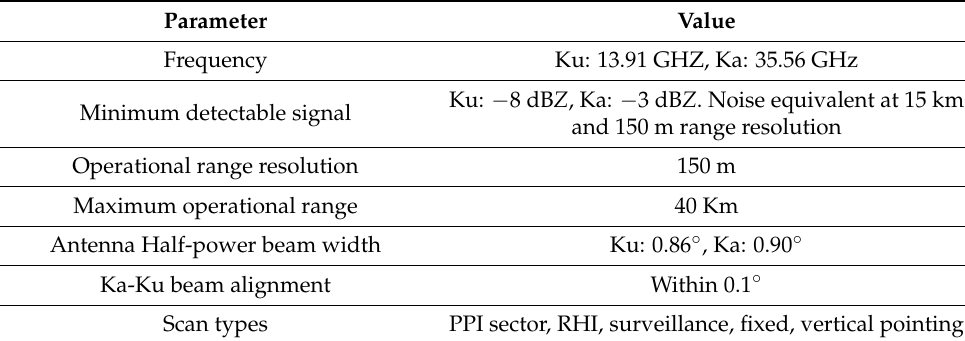
Figure 2. A picture of the D3R radar located at the CSU-CHILL radar facility. Table 2. Specifications of the D3R radar. Table 2. Specifications of the D3R radar.